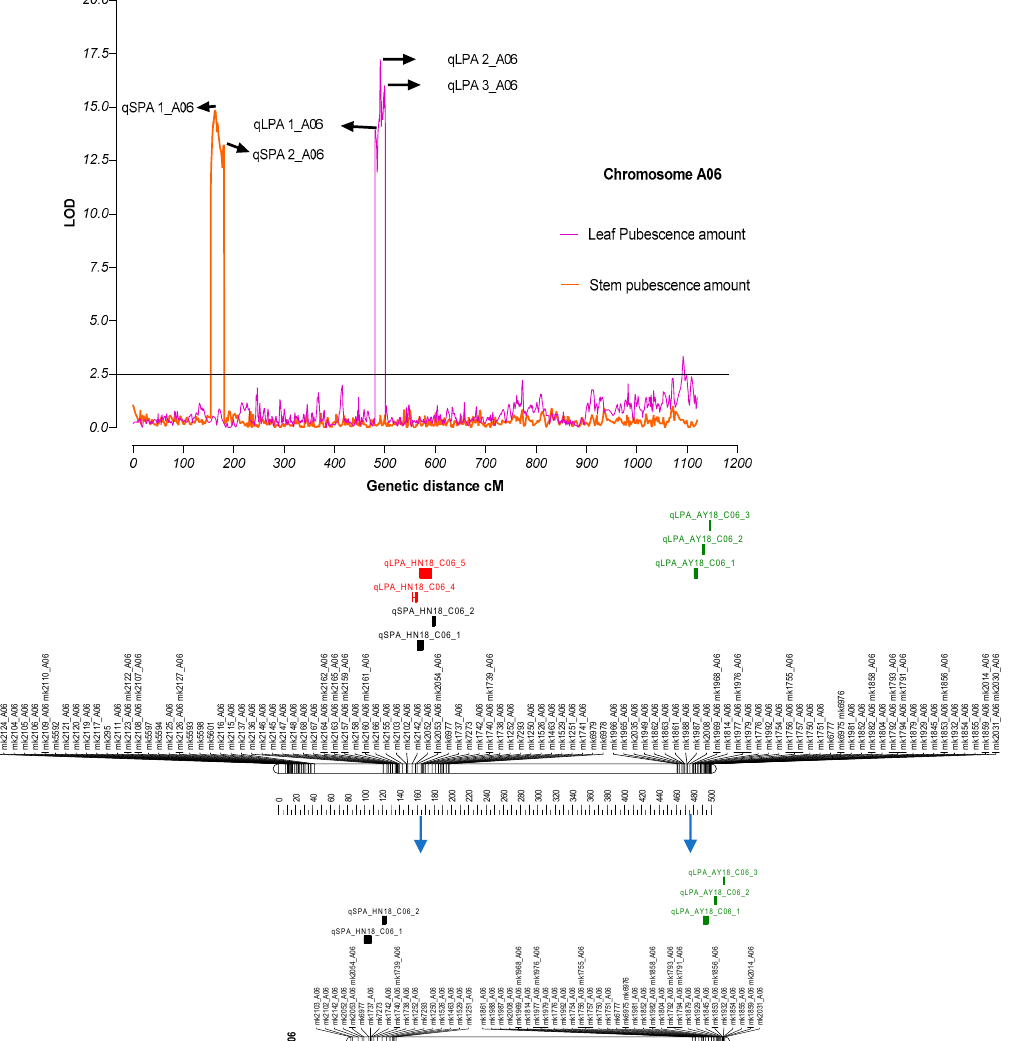
Figure 2. Physical representation of QTLs on chromosome A06 for leaf and stem pubescence. Vertical lines on the upper side of the figure indicating LOD values for leaf and stem pubescence against their genetic distances in centimorgan. Arrow signs show the location of QTLs for the respected trait. The lower portion indicates physical representation of QTLs on Chromosome A06.